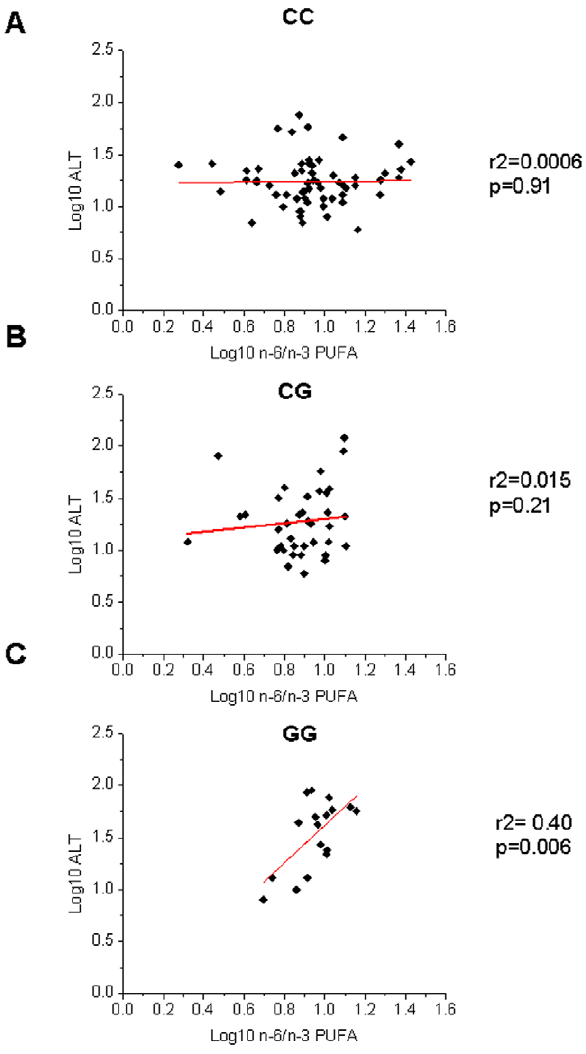
Figure 2. Interaction between PNPLA3 rs738409 and n-6/n-3 PUFA in modulating ALT levels. The figure shows a different degree of regression between ALT (log10) and n-6/n-3 PUFA (log10) in the three genotypes. In the CC (Panel A) and CG (Panel B) group there was no association between ALT and n-6/n-3 PUFA (r2=0.0006, p=0.91 and r2=0.015, p=0.21 respectively). Only in the GG group (Panel C) there was a strong association between HFF% and n-6/n-3 PUFA (r2= 0.40, p=0.006).